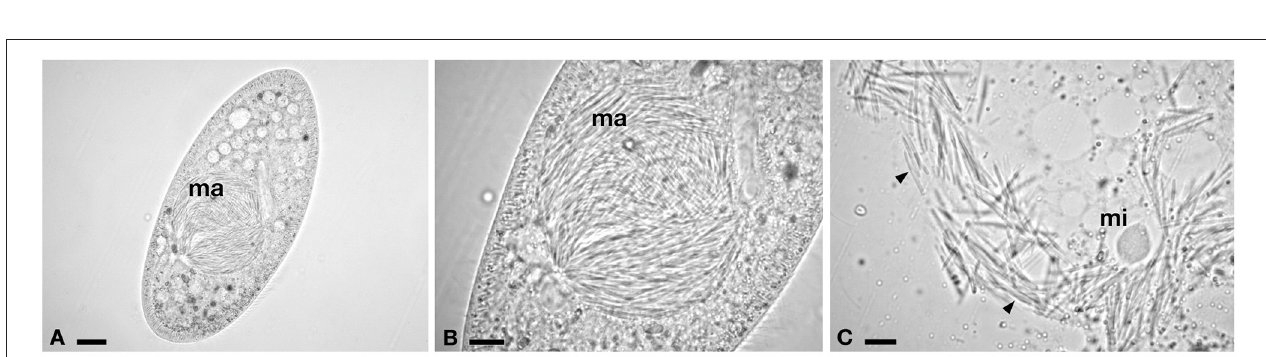
FIGURE 3 | Light microscopy of infected P. caudatum SH2. (A) Whole cell with macronuclear infection. (B) Detail of hyperinfected macronucleus ( ma ). (C) Compact type micronucleus ( mi ) and rod-shaped bacteria, released after ma squashing. Arrowheads indicate infectious forms. Bars stand for 20 µ m (A) and 10 µ m (B,C)